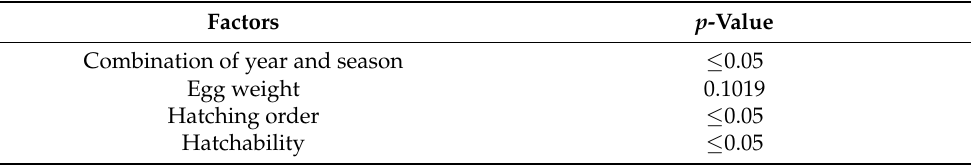
Table 5. The p -values of factors affecting the relative risk of chick survival. Factors p -Value Combination of year and